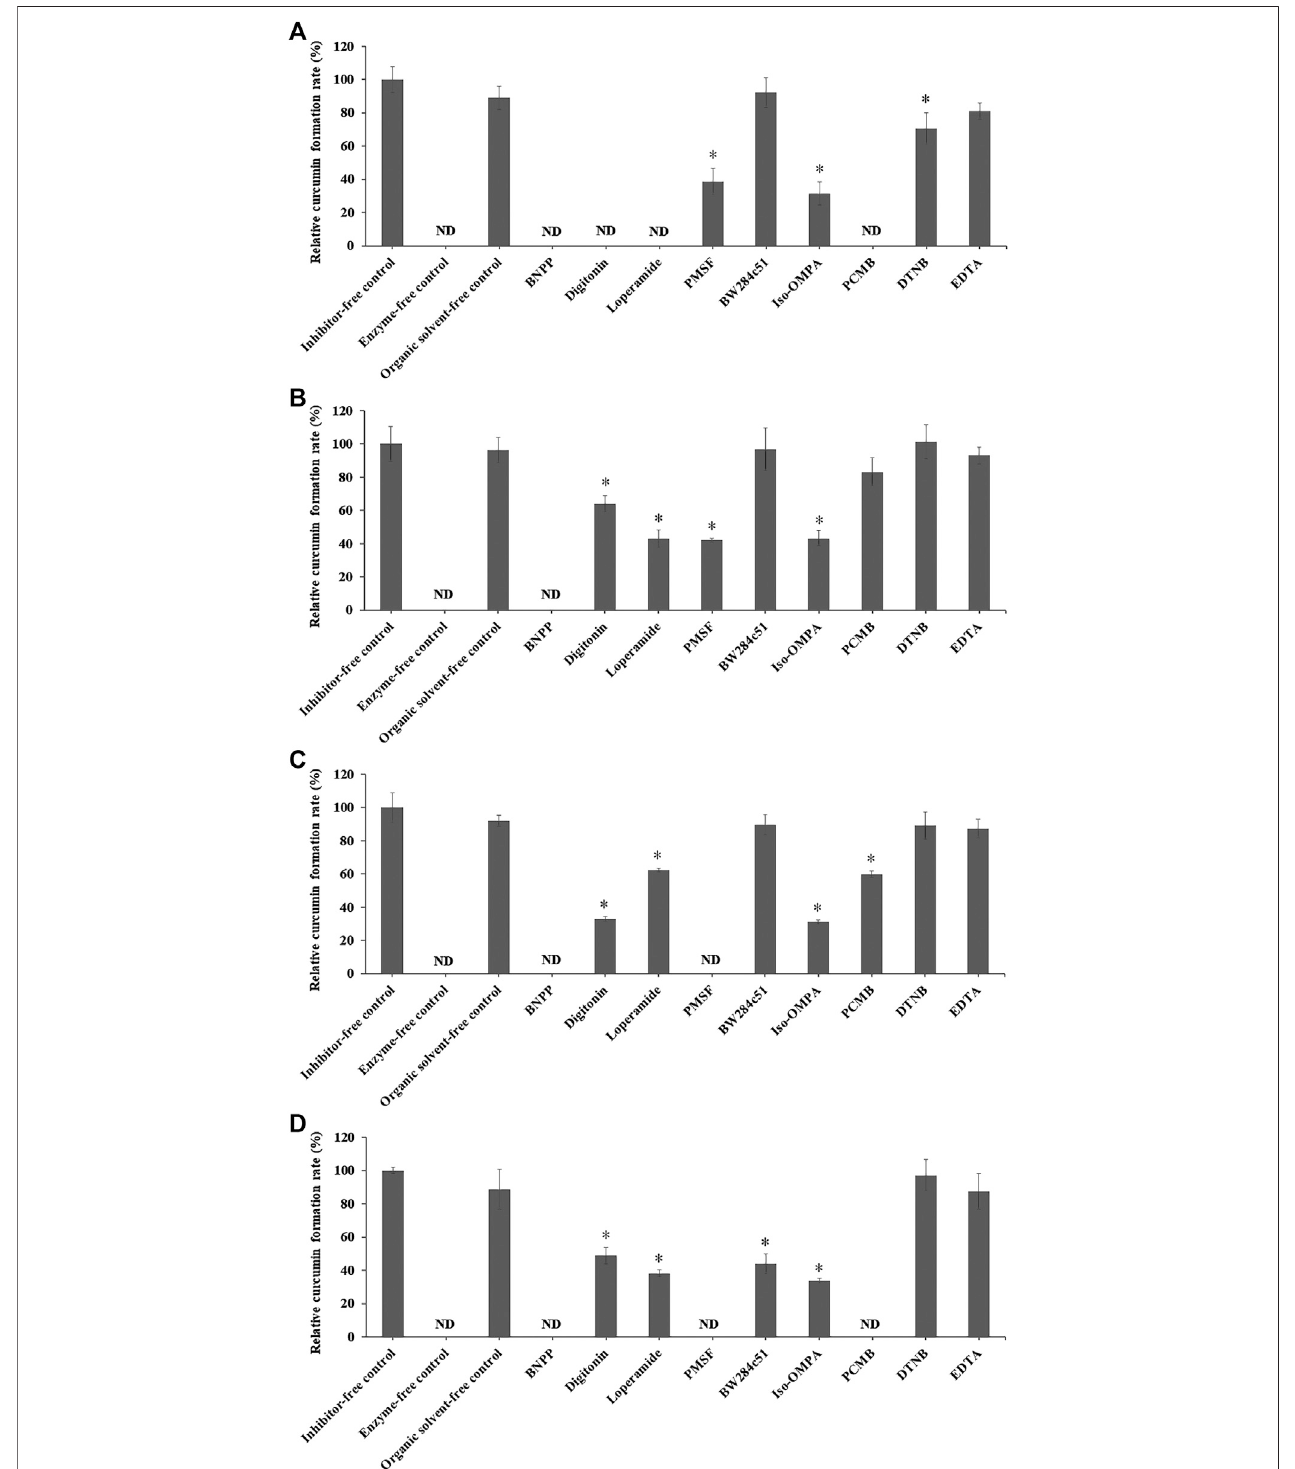
FIGURE 5 | Relative curcumin formation rate ofCDD (3 µM) incubated with (A) HLS9, (B) MLS9, (C) DLS9, and (D) RLS9 (0.02 mg/ml) in the presence ofdifferent inhibitors.Controlwasprepared by incubating CDD inLS9withoutinhibitors.One-way ANOVA analysiswith Dunnett ’ s post hoc test: ND (cid:2) notdeterminedbecausethe curcumin concentration was below the lower limit of quanti fi cation; *statistically signi fi cant vs. control p < 0.001.